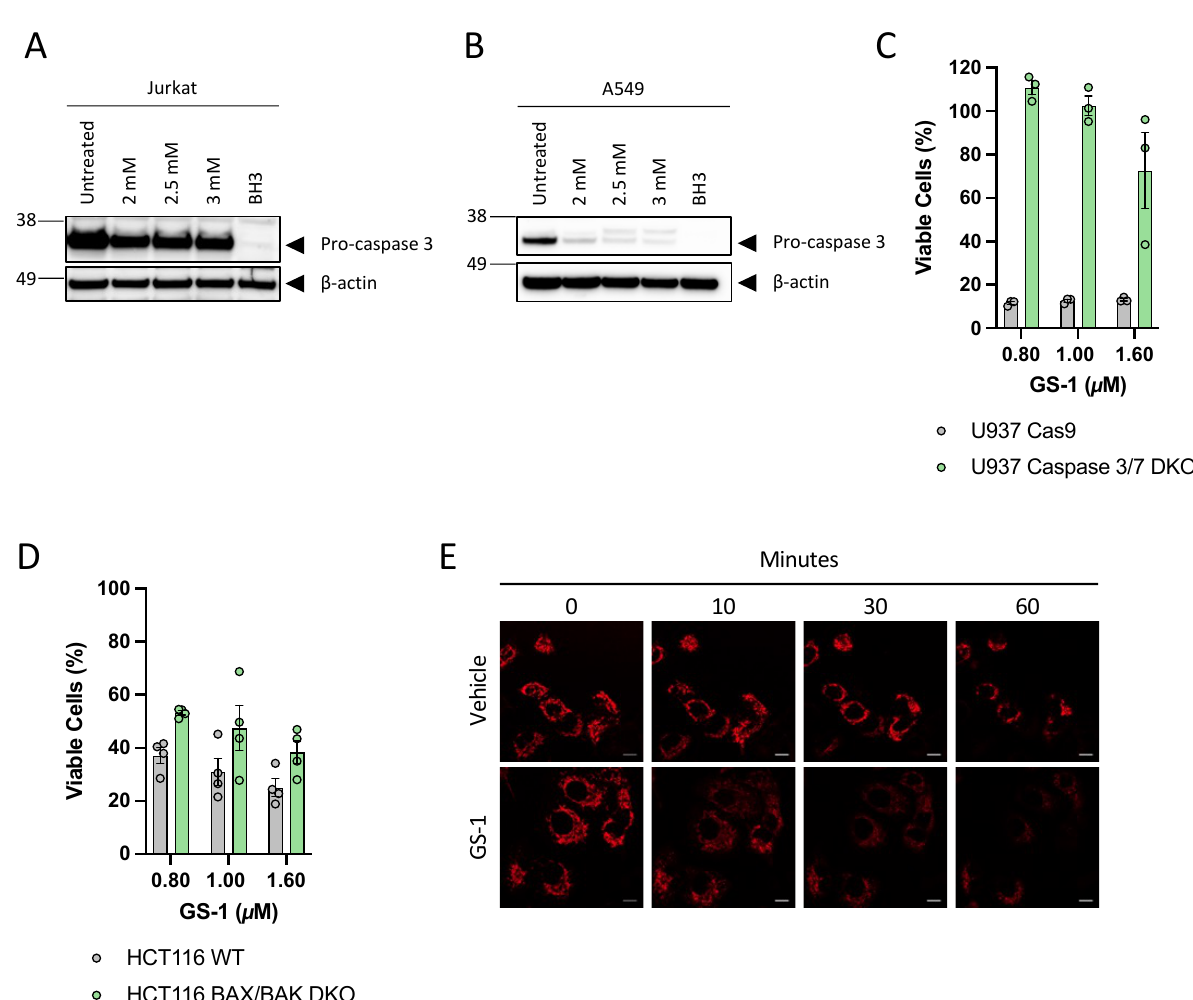
Figure 3. GS-1 toxicity relies on pro-apoptotic proteins. ( A ) Jurkat and ( B ) A549 cells were treated with increasing concentrations of GS-1 for 6 h before immunoblotting to determine pro-caspase 3 levels (representative of n = 3 independent experiments). ( C ) U937 WT and Caspase 3/7 DKO cells were treated with increasing concentrations of GS-1 before undergoing an MTS assay to determine viability (n = 3, ± S.E.M.). ( D ) HCT-166 WT and Bax/Bak DKO cells were treated with increasing concentrations of GS-1 before undergoing an MTT assay to determine viability (n = 3, ± S.E.M.). ( E ) Confocal time course microscopy analysis of A549 cells stained with MitoTracker Red and treated with GS-1 to determine change in mitochondrial membrane potential (scale bar 10 µ m; images representative of 3 experiments).